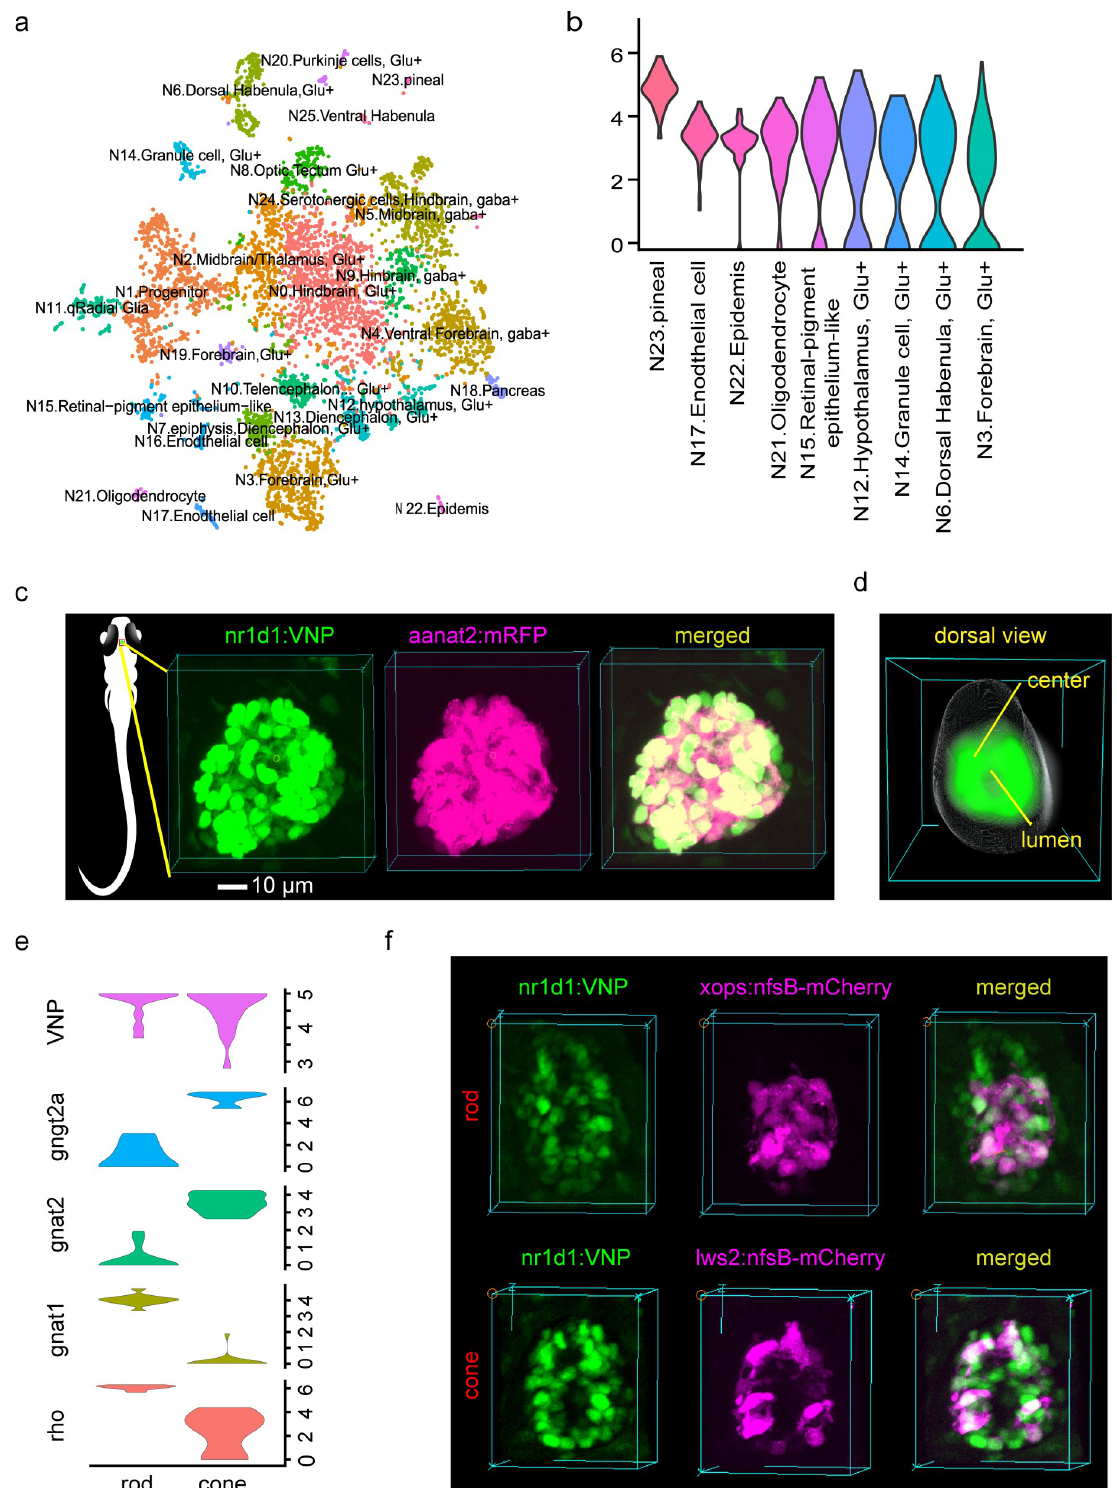
Fig 2. Characterization of nr1d1 :VNP expressing cells. (a) t-SNE visualization of brain cell clusters. The clusters were annotated by comparing to the adult zebrafish scRNA-seq data. (b) Violin plot demonstrated the clusters with enriched expression of nr1d1 :VNP. Y axis denotes the normalized expression value. Note the highest levels in the pineal gland. (c) Fluorescence images show the co-expression of